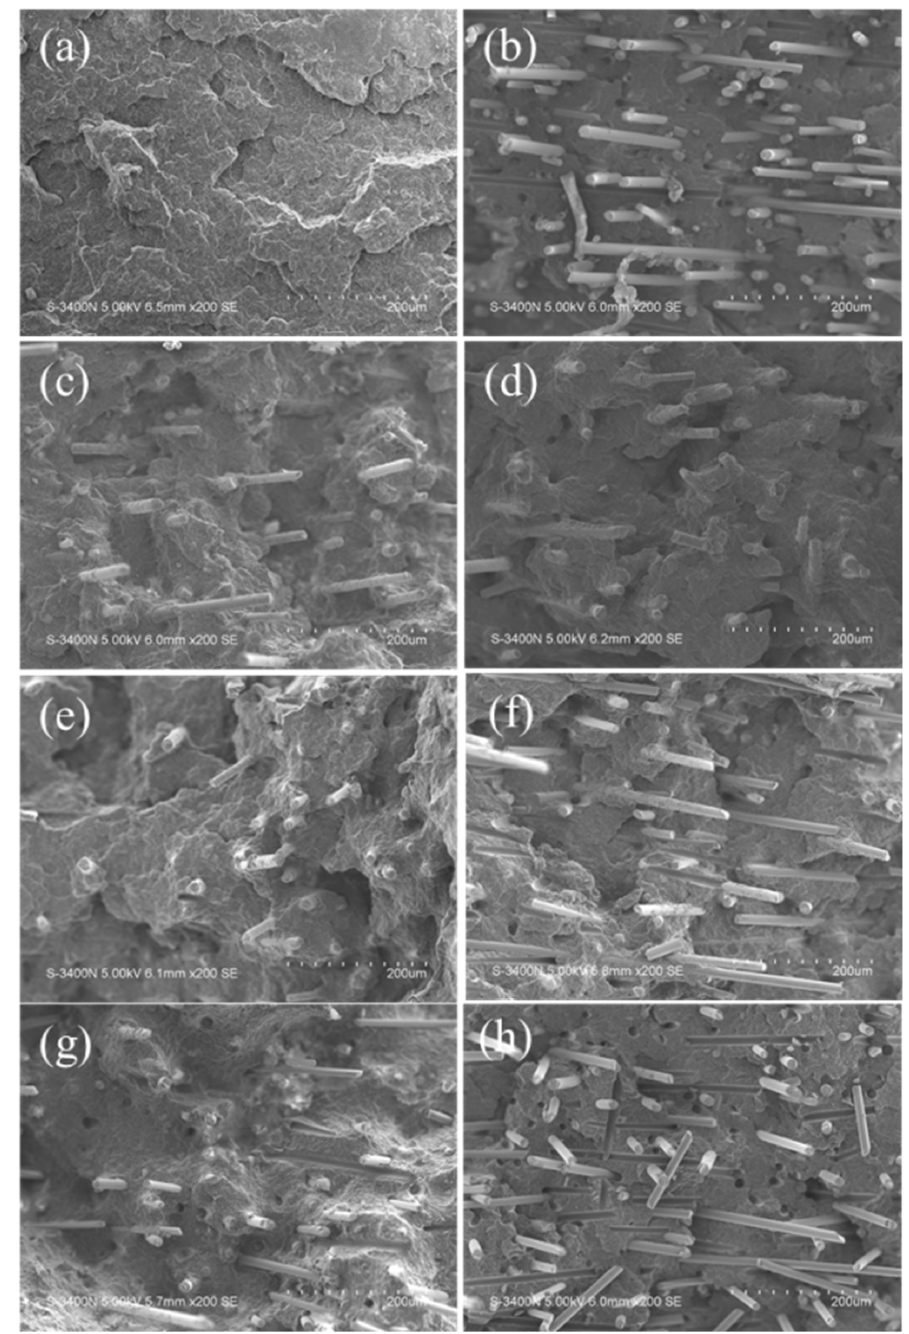
Figure 6. Scanning electron microscope (SEM) images of GFRP composites with different compatibilizers: ( a ) Pure PP; ( b ) GFRP-30; ( c – e ) GFRP-PP-5, GFRP-PP-10, GFRP-PP-15; ( f – h ) GFRP- POE-5, GFRP-POE-10, GFRP-POE-15.